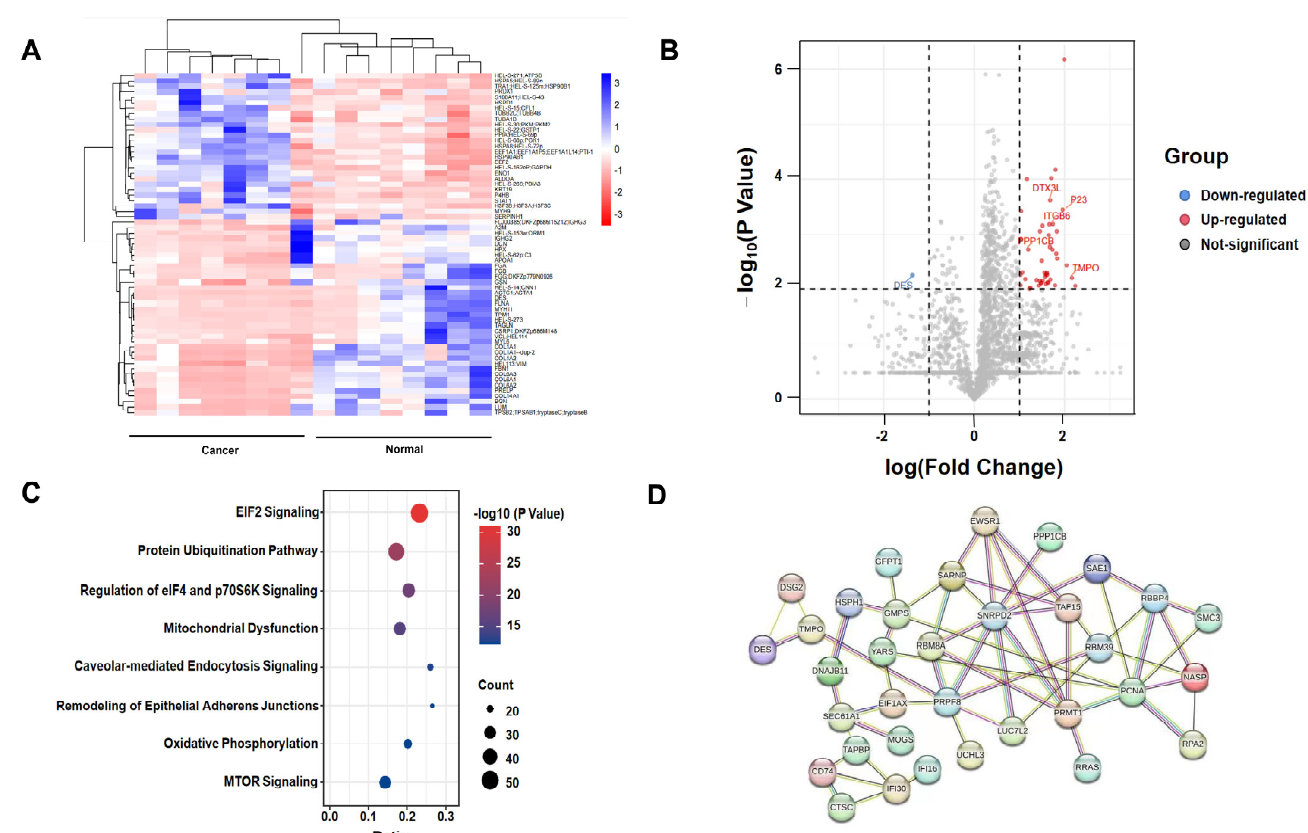
Figure 1. Differential proteomics analysis between CC and adjacent normal tissues. ( A ) Heat map of DEPs is shown between cancer tissues and adjacent normal tissues. The analysis was achieved by using Hiplot (https://hiplot ‐ academic.com, accessed on 1 September 2021). ( B ) Volcano plot illustrating significant DEPs from the quantitative analysis. The − log 10 ( p ‐ value) is plotted against log 10 (Fold Cancer/Normal). The red and blue dots indicate the significantly upregulated and downregulated proteins in CC tissues separately. ( C ) Ingenuity Pathway Analysis (IPA) of 708 DEPs. ( D ) PPI network analysis of 46 significant DEPs.